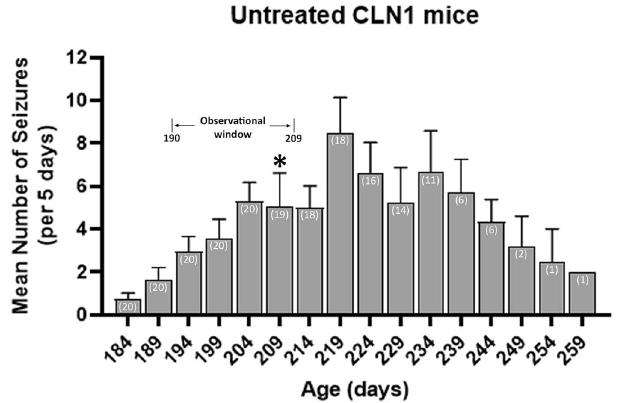
Figure 3. Trajectory of seizures in Cln1 −/− mice. Seizure occurrences were summed into 5-day bins, and mean seizure counts (+ SEM) are shown. The first of 20 mice died at PND 209, indicated with an asterisk. Number of surviving mice is included in white text within each bar. Selected observational window is shown here, indicating the span during which seizures were measured in the cohort of mice receiving chronic treatment. Data is shown for all living mice until the last mouse died at PND